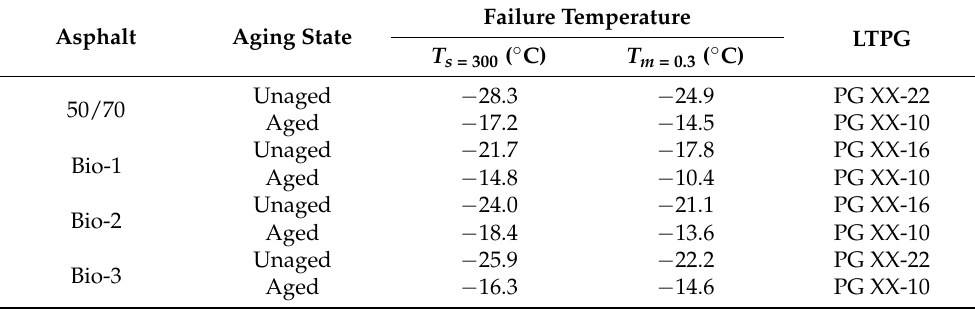
Table 3. Classical BBR test results of all the asphalt samples.